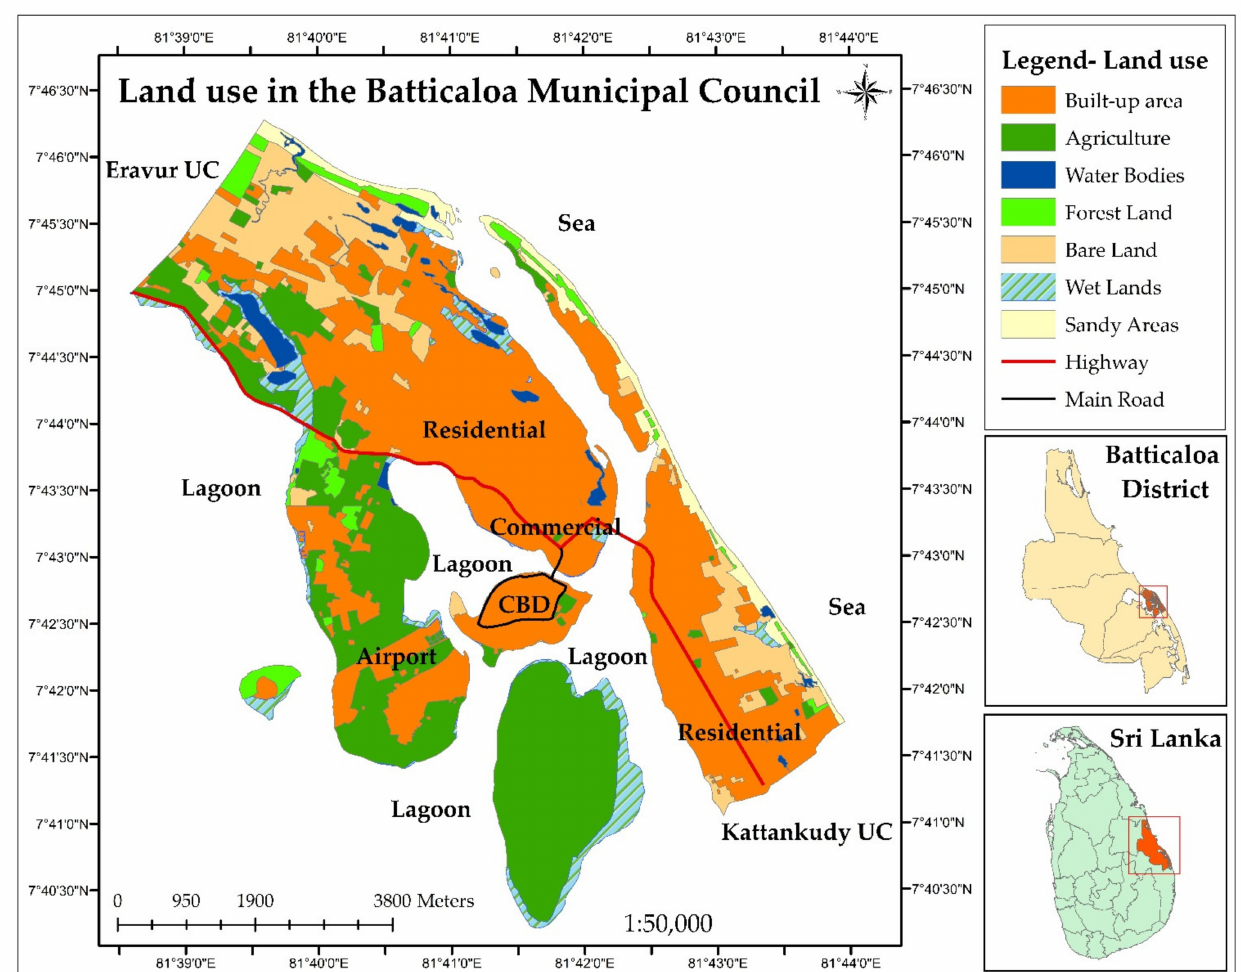
Figure 2. The Study Area—Land use pattern in the Batticaloa Municipal Council—2020. Source: Modified from the Batticaloa Municipal Council Profile, 2021.